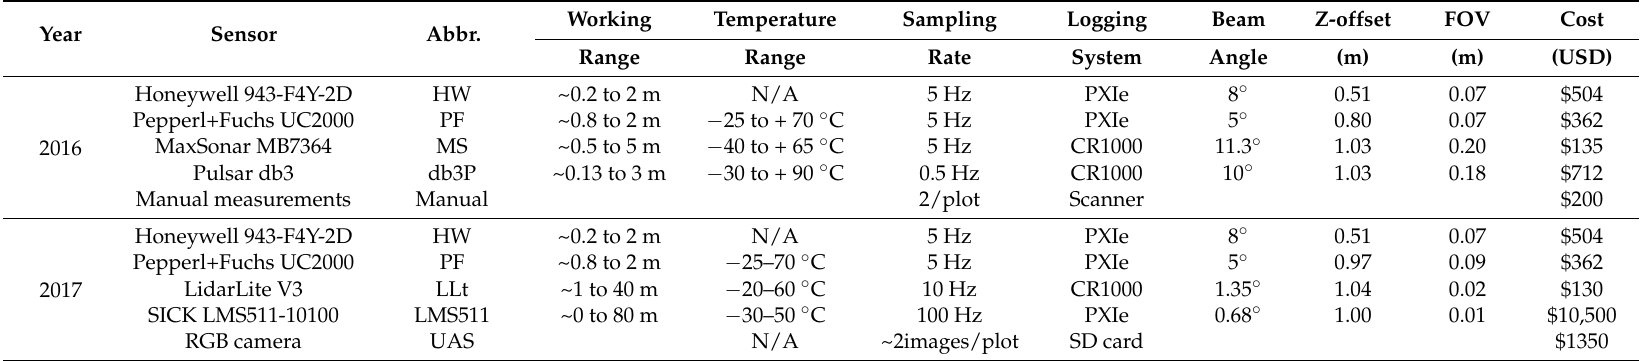
Table 1. List of abbreviations (Abbr.), operation ranges, sampling rate and logging system, beam angle, z-offset, calculated field-of-view (FOV), and approximate cost for each sensor technology used in 2016 and 2017 measurements of cotton plant